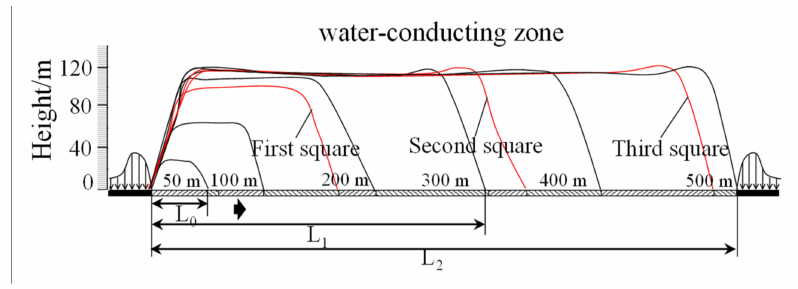
Figure 9. Evolution of the water-conducting fracture